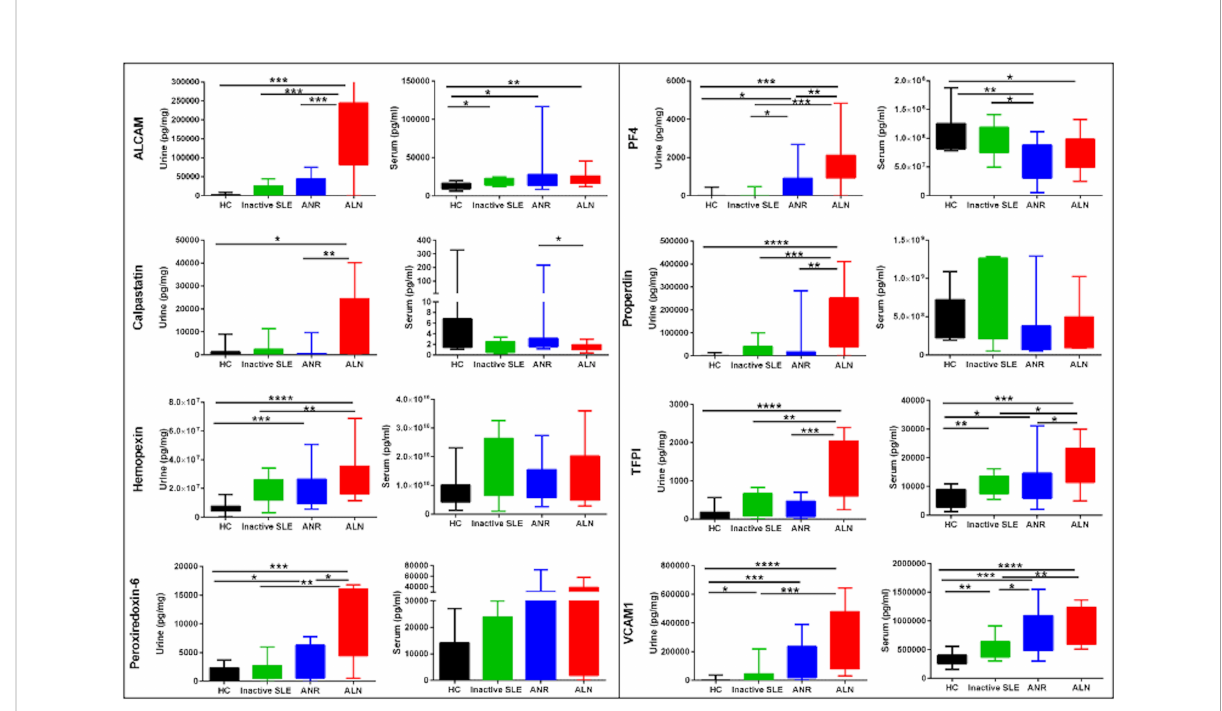
FIGURE 1 Serum and urine levels of 8 protein biomarkers in SLE patients and controls. The Y axes show the values of the 8 studied biomarkers (inter- quartile and range), while the X axes display the 4 groups interrogated (12 healthy controls; 12 inactive SLE; 12 active non-renal SLE; 12 active renal disease(LN)). Urinary biomarker levels were normalized to urinary creatinine. Within each set of plots, the urine pro fi les are plotted to the left (Cr normalized), while the serum pro fi les are presented to the right. The urine biomarker data has been reported previously (8). * = P<0.05, ** = P<0.01, *** = P<0.001, **** = P<0.0001.